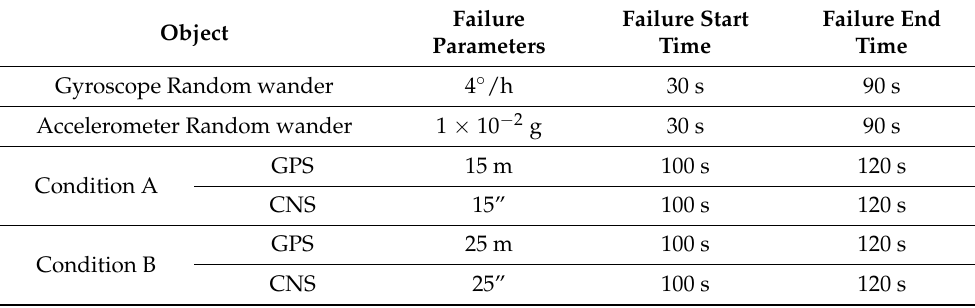
Table 2. Fault parameters